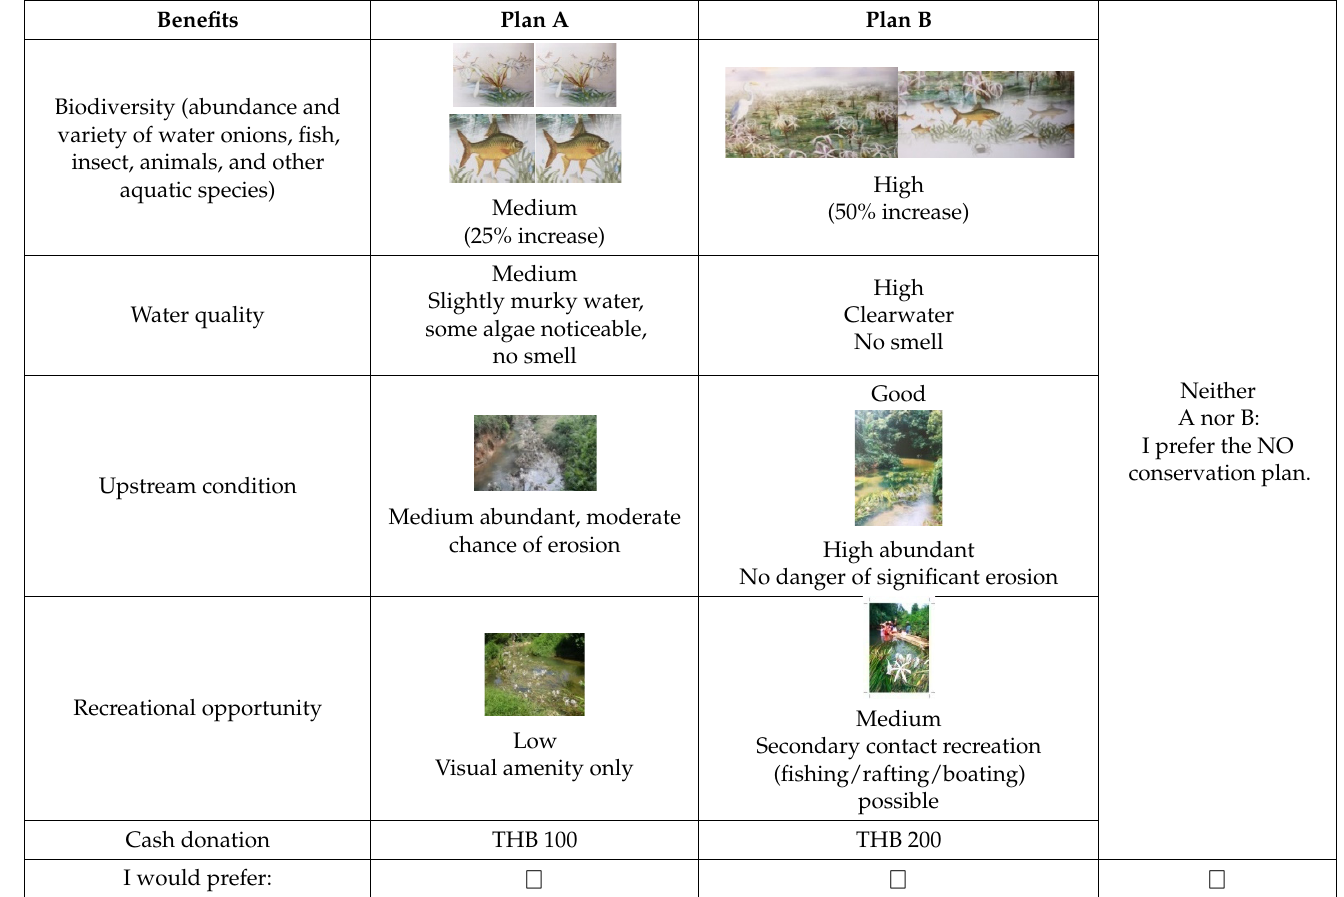
Table 3. Example of a choice set for the CE task in volunteer labor terms.